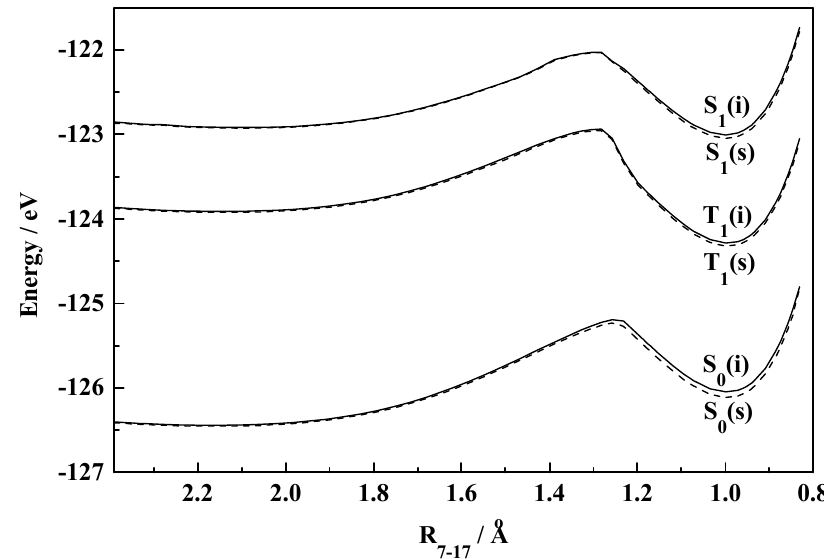
Figure 7. Simulated PECs for IPT process of HBO in S ethanol).